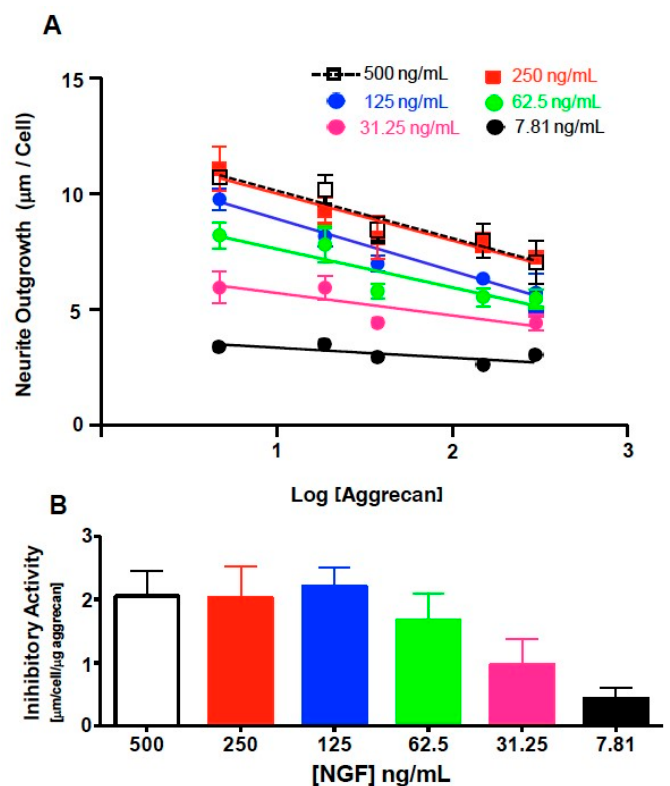
Figure 5. Graphical analysis of inhibitory activity. ( A ) Neurite outgrowth at 500, 250, 125, 62.5, 32.15, and 7.81 ng / mL NGF are graphed as a function of the log of the aggrecan concentration. ( B ) Bar graph plotting the inhibitory activity as a function of NGF concentration.